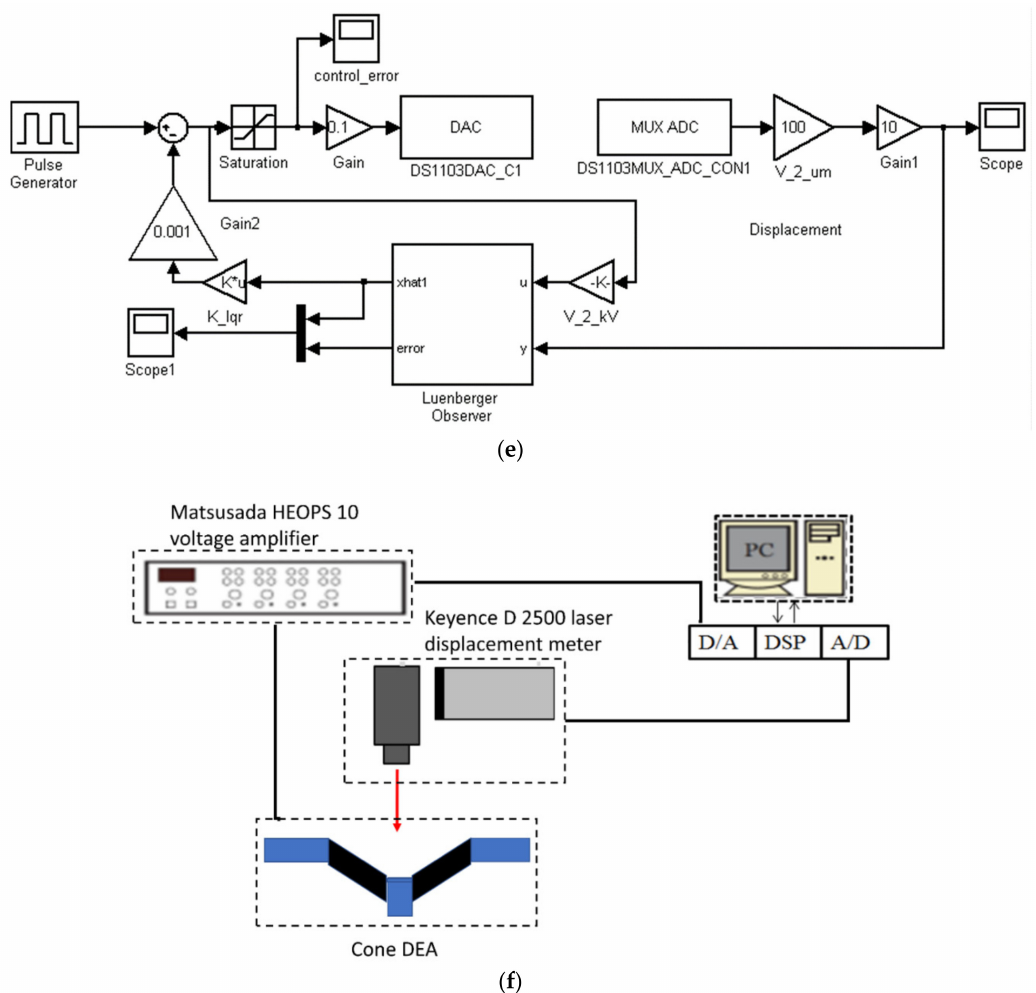
Figure 2. ( a ) The basic linear quadratic regulator controller; ( b ) A Luenberger observer; ( c ) An LQR controller having a Luenberger observer; ( d ) a plant model detail for the cone DEA; ( e ) LQR controller for real-time closed-loop experiment; and, ( f ) Block diagram for the experimental setup for the control of the cone